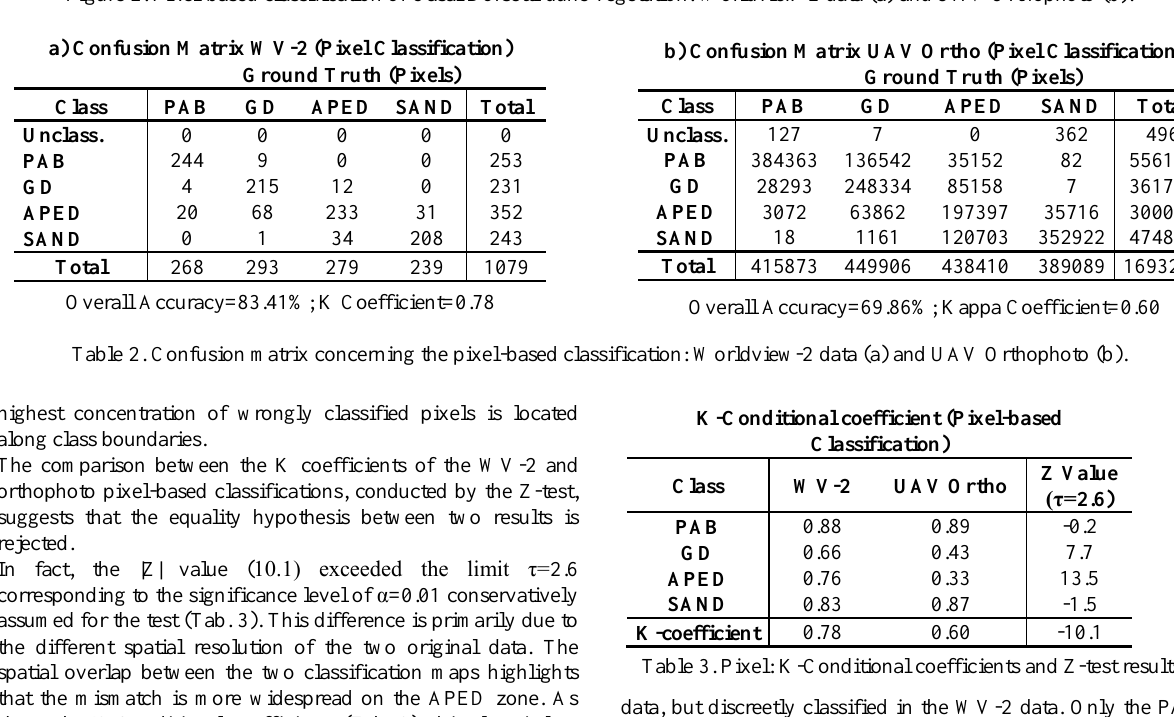
Figure 2. Pixel-based classification of Casal Borsetti dune vegetation: Worldview-2 data (a) and UAV Orthophoto (b).